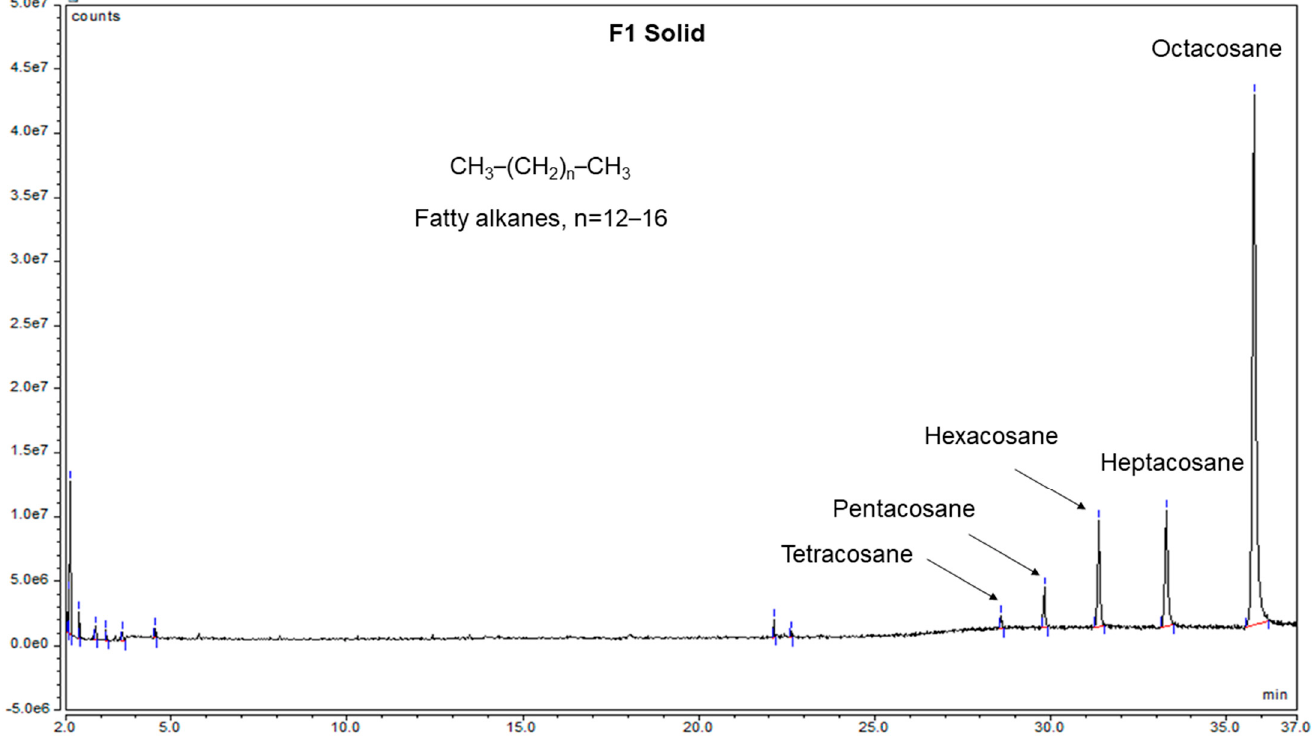
Figure 1. GC–MS chromatogram of the F1 solid.